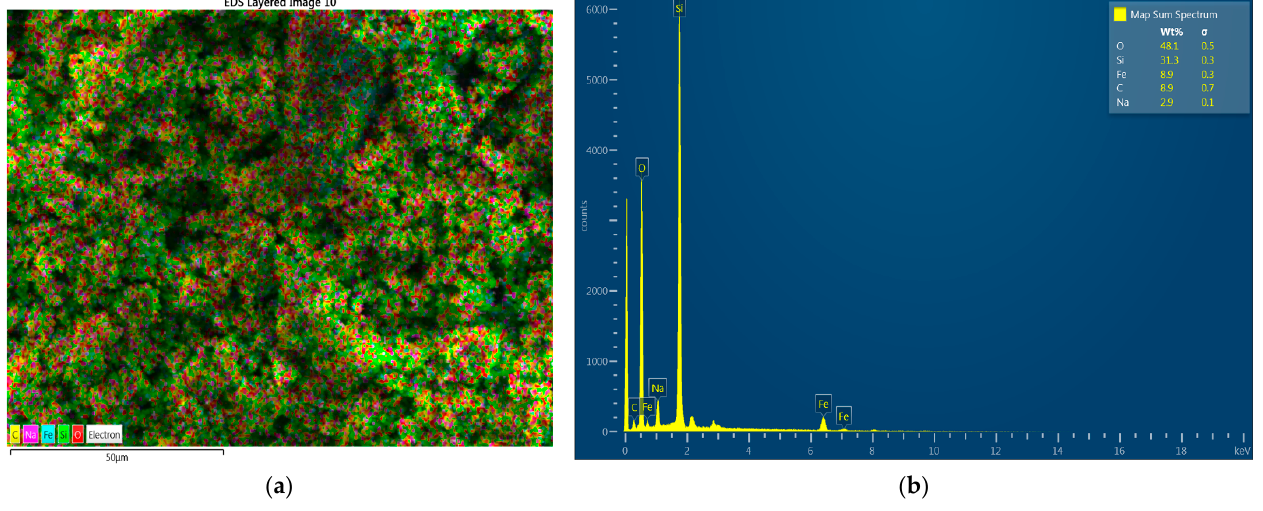
Figure 9. EDS image of modified Fe 3 O 4 NPs: ( a ) EDS colorization layer of identified elements in a SEM micrograph of modified Fe 3 O 4 NPs, ( b ) EDS spectrum of modified Fe 3 O 4 NPs containing O, Si, Fe, C, Na.